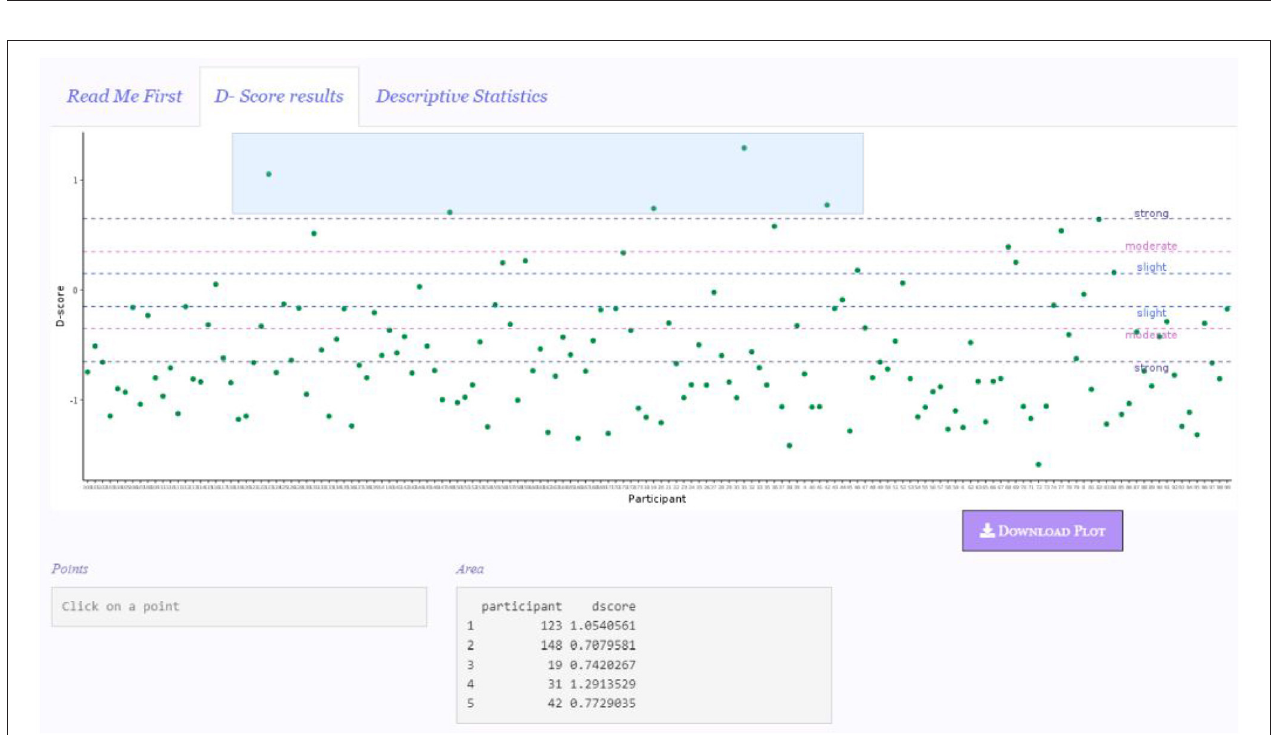
FIGURE 3 | Shiny App graphical representations. (A) Points (default). (B) Histogram. (C) Density. (D) Histogram and Density.